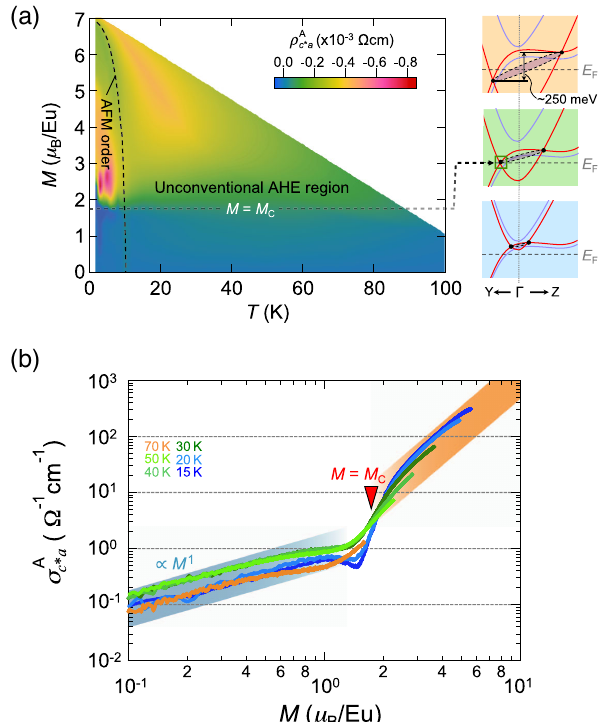
FIG. 3. Anomalous Hall effect in α -EuP 3 under B k b . (a) Color plot of the anomalous Hall resistivity ρ c (cid:2) aA ¼ ρ c (cid:2) a − ρ c (cid:2) aT ¼ 150 K as a function of M and T . AFM denotes antiferromagnetic. The schematics on the right side illustrate the M -dependent evolution of the nodal ring shown in Fig. 4(d). Further explanations based on DFT calculations are presented in the Supplemental Material [37]. (b) Anomalous Hall conductivity σ c (cid:2) aA ¼ − ρ c (cid:2) aA = ð ρ aa ρ c (cid:2) c (cid:2) − ρ ac (cid:2) ρ c (cid:2) a Þ as a function of M . Further discussions on the analysis are presented in the Supplemental Material [37].